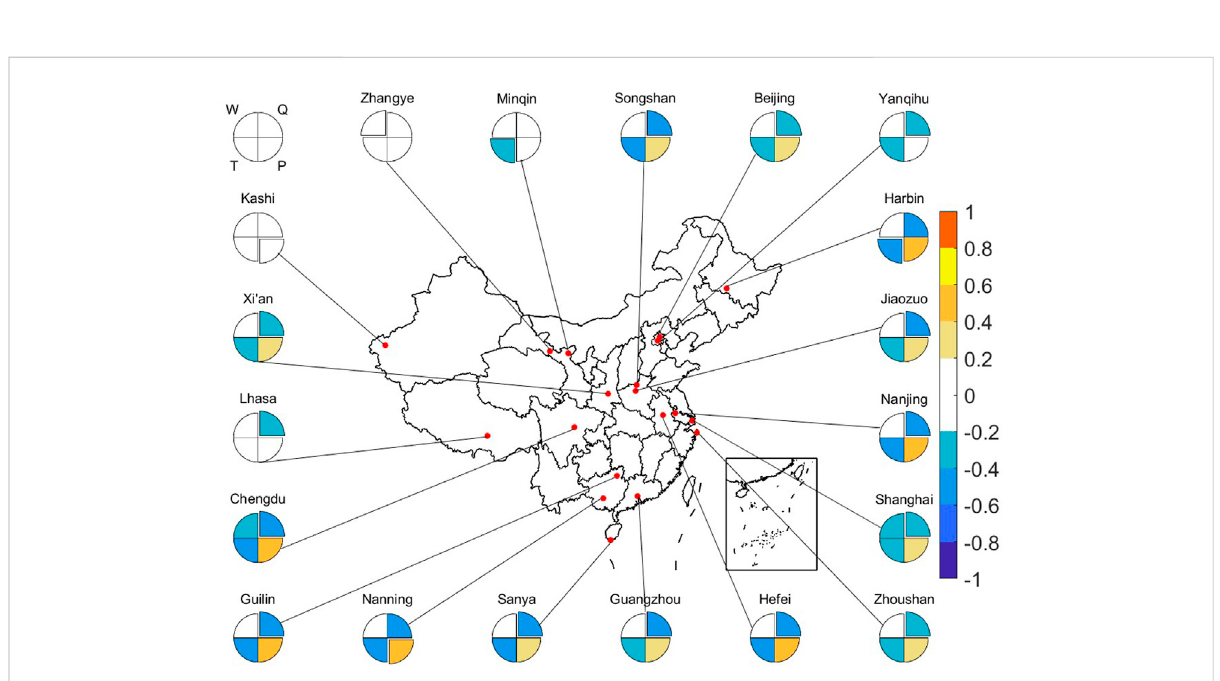
FIGURE 5 Correlationcoef fi cientsbetweenmeteorologicalvariablesfromERA5reanalysesandthenormalizeddifferencesofPM 2.5 andAODat19SONET sites in China from 2017 to 2019. The four parts of the pie chart correspond to wind speed (W), speci fi c humidity (Q), surface air temperature (T), and sea level pressure (P), respectively. The dominant factor with the highest correlation coef fi cient is